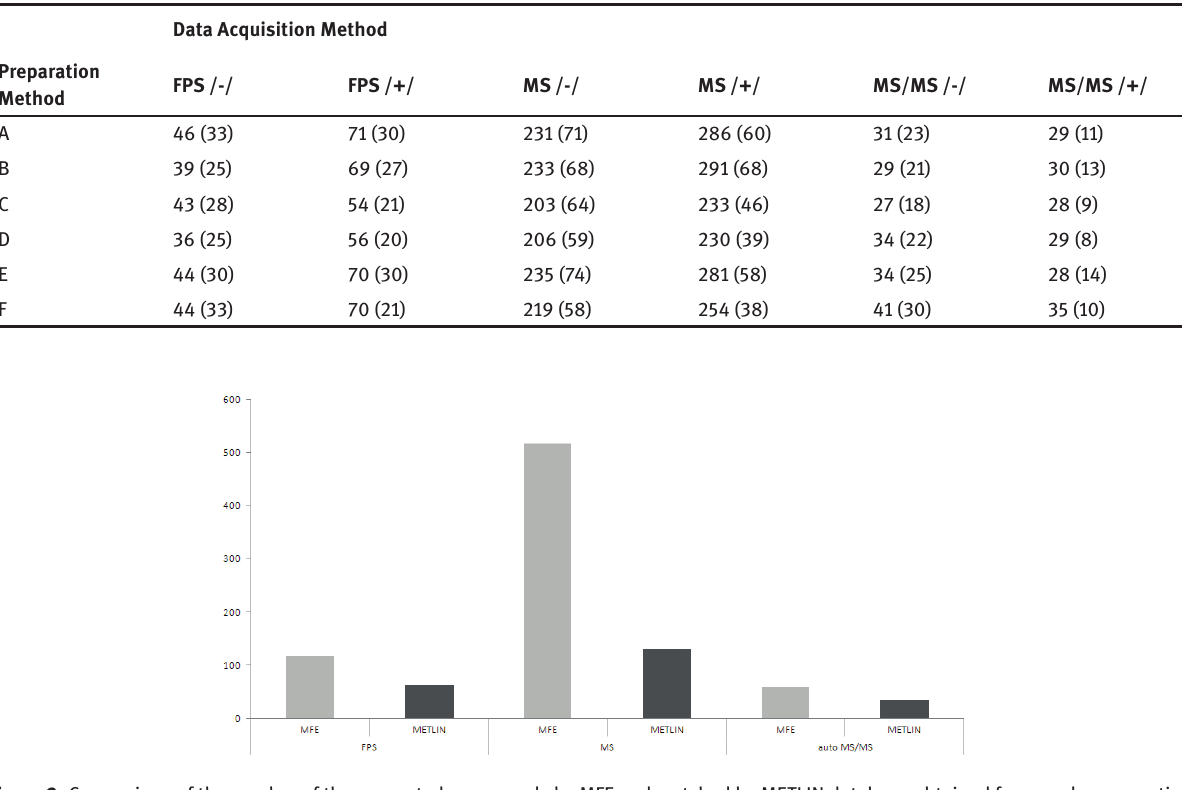
Figure 2: Comparison of the number of the generated compounds by MFE and matched by METLIN database obtained for sample preparation method A (sum for both